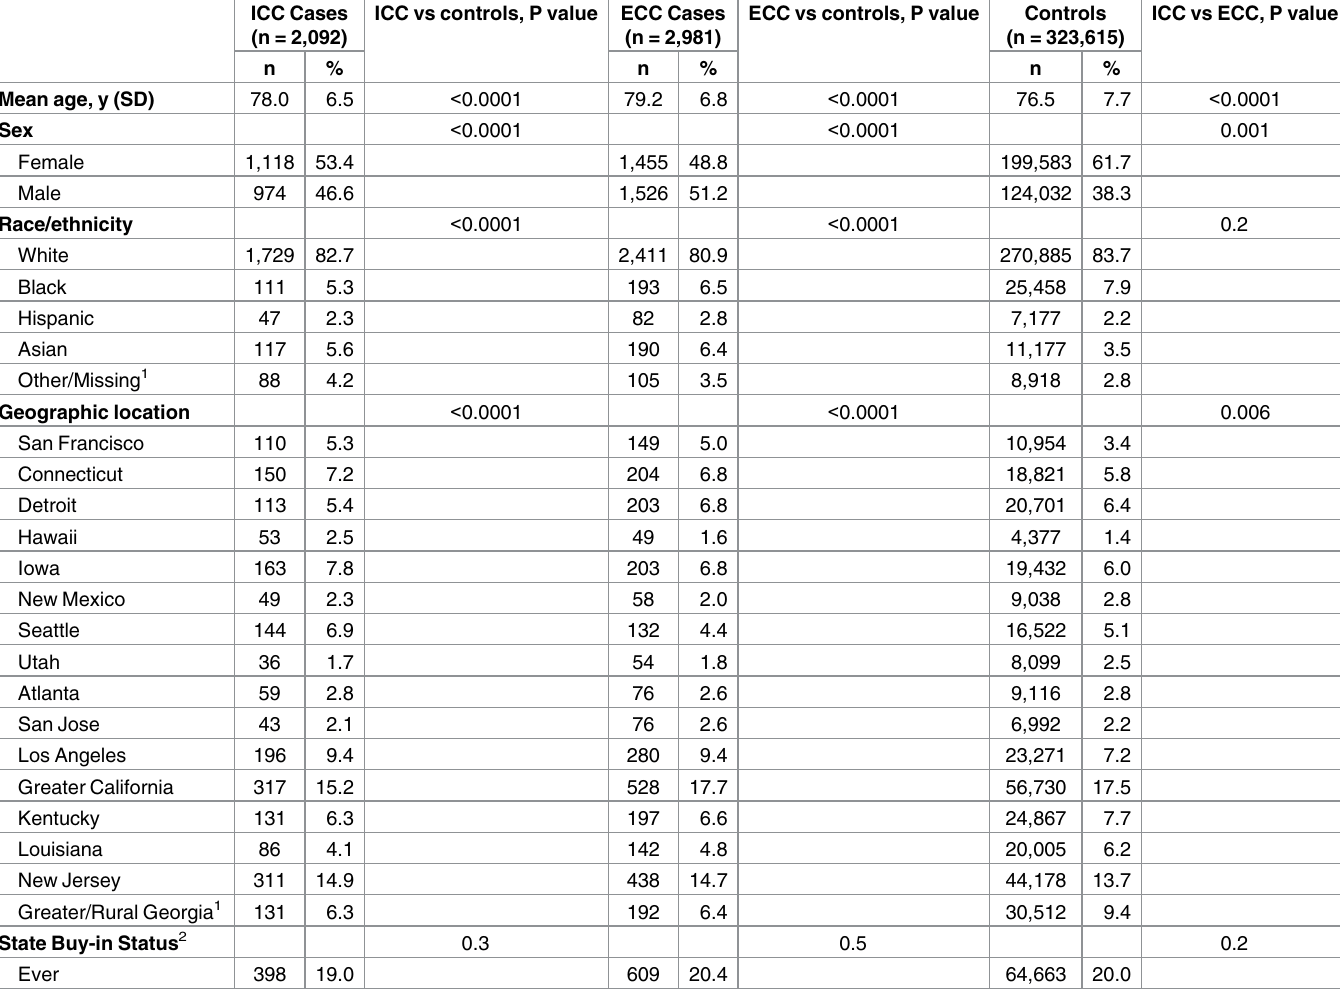
Table 2. Demographic characteristics of the study participants, SEER-Medicare 2000–2011.